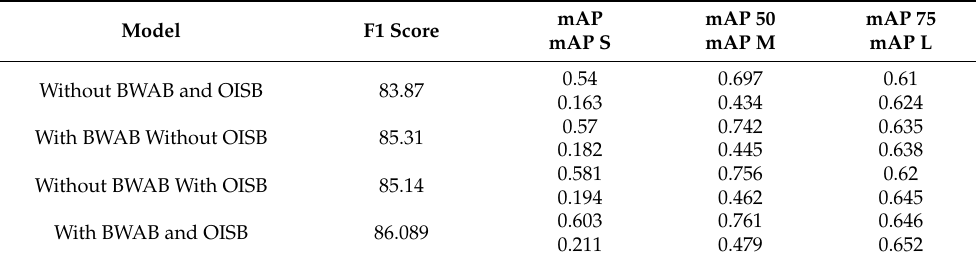
mAP mAP 50 mAP 75 mAP S mAP M mAP L